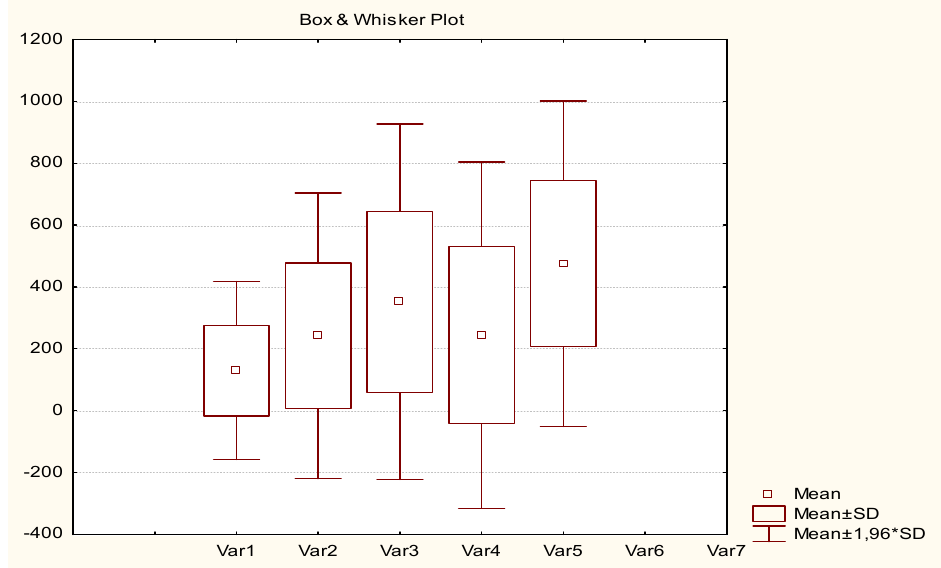
Figure 5. Distribution of radon concentrations in 2021 in schools from Chisinau region. Var 1—Kin-